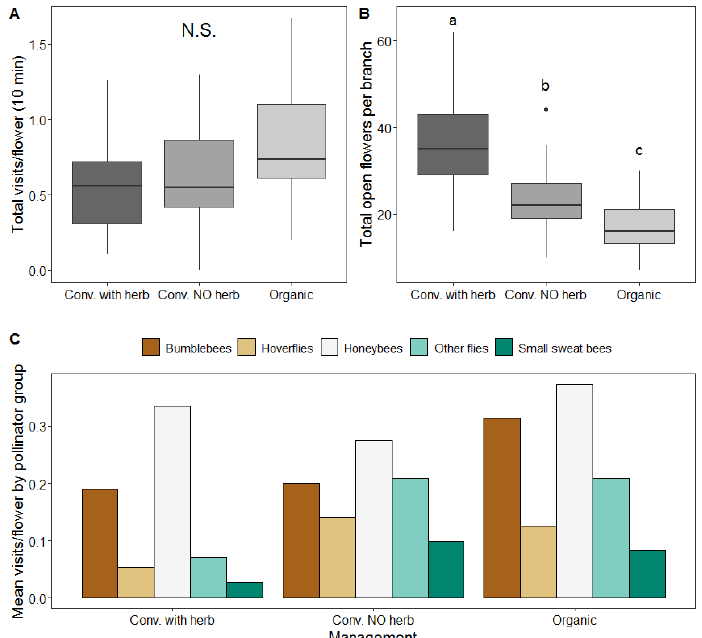
Figure 2. ( A ) Total insect visits per open flowers in 10 min observations according to management; ( B ) Number of open flowers per branch according to di ff erent management systems; ( C ) Mean visits per flower for main pollinator groups according to management. N.S. denotes non-significant e ff ects, and di ff erent letters represent significant e ff ects between levels. The black horizontal line is the